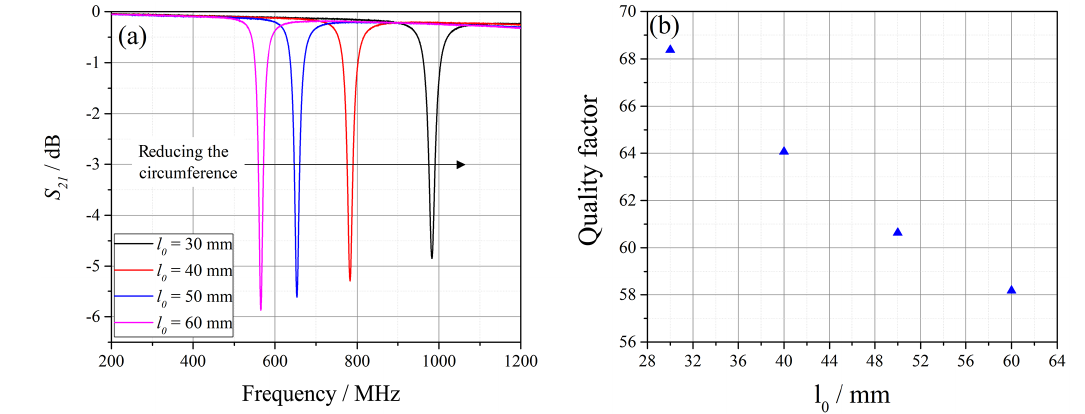
Figure 17. Influence of the circumference of the resonator structure on the resonance frequency: (a) transmission measurement; (b) quality factor.